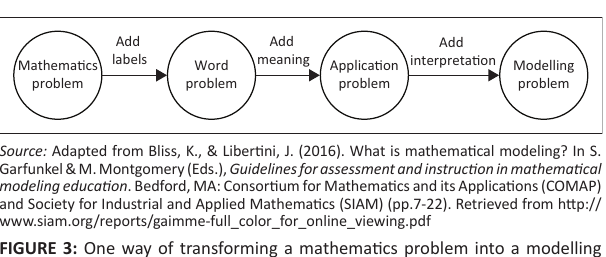
FIGURE 3: One way of transforming a mathematics problem into a modelling problem.